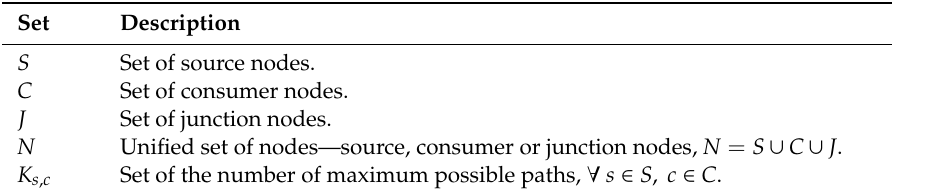
Table 2. Sets of the optimization